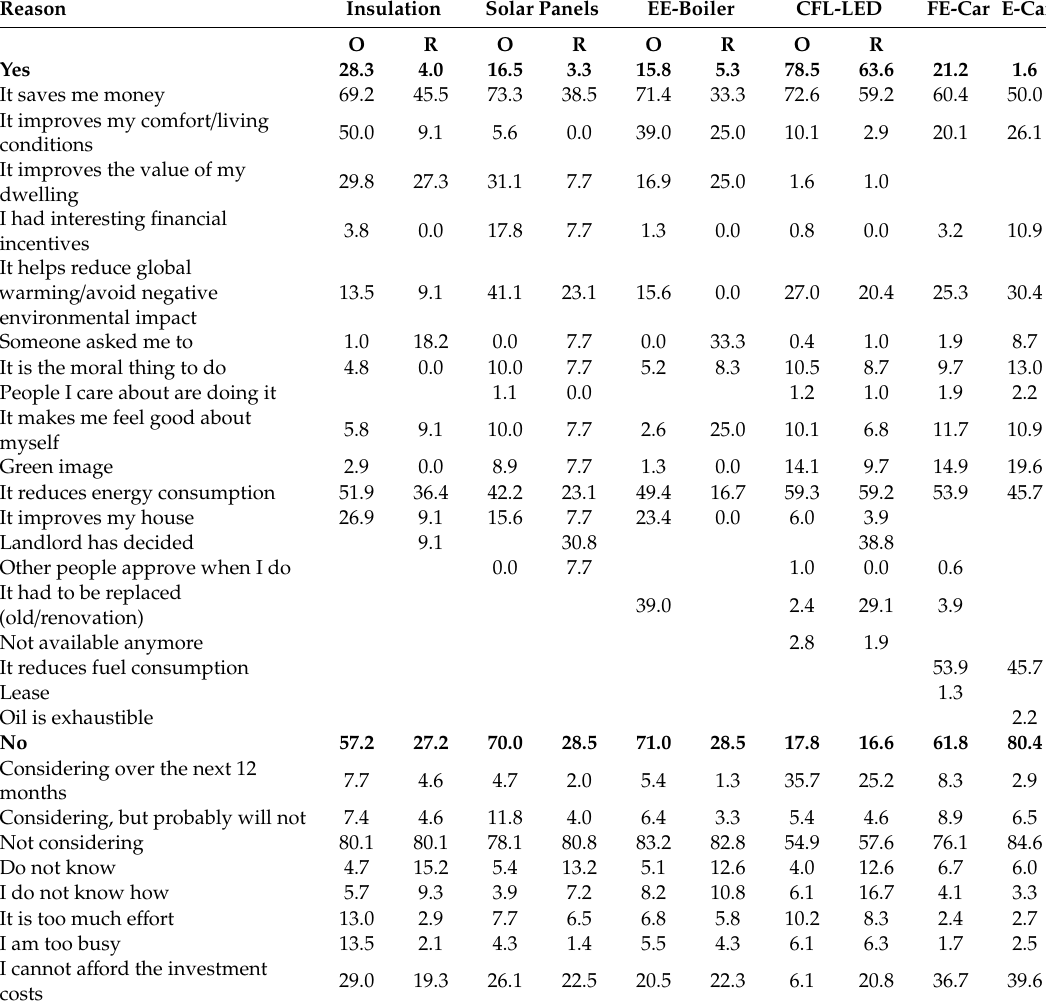
Table 3. Technical energy saving